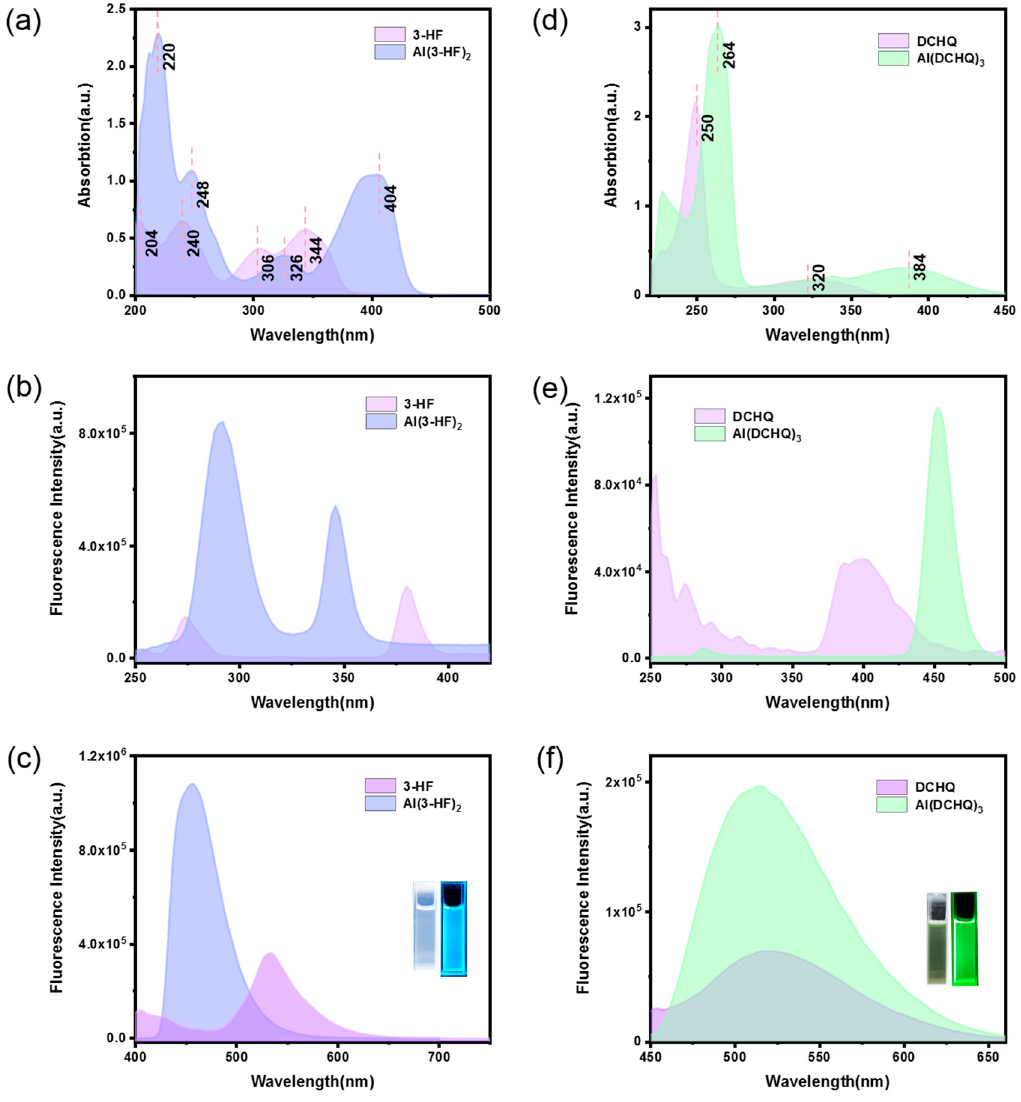
Figure 4. Comparison of ( a ) UV–VIS absorbance spectra, ( b ) excitation spectra, and ( c ) fluorescence intensity of 3-HF and Al(3-HF) 2 . Comparison of ( d ) UV–VIS absorbance spectra, ( e ) excitation spectra, and ( f ) fluorescence intensity of DCHQ and Al(DCHQ) 3 .